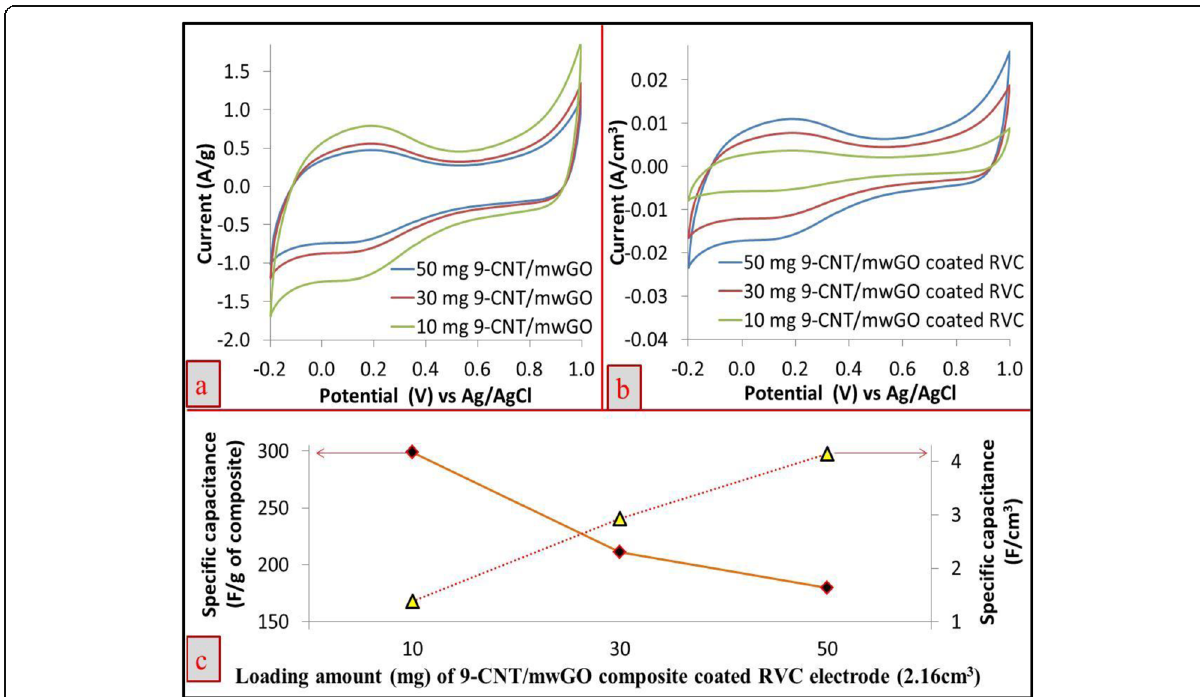
Fig. 3 CV of 9-CNT/mwGO composite-coated RVC electrodes in terms of a current per gram of composite and b current per geometric volume of electrode. c Capacitance of the electrodes per gram of composite and per geometric volume of the